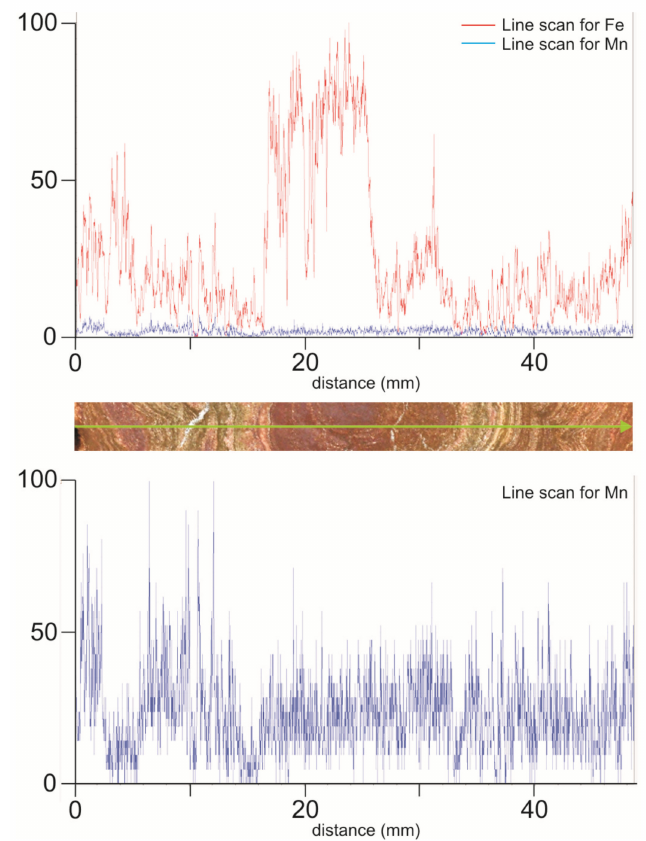
Figure 10. Line scan for Fe and Mn obtained with XR-microfluorescence of a transect of the iron macro-oncoid of the Figure 8 (Note: y-axis indicates number of